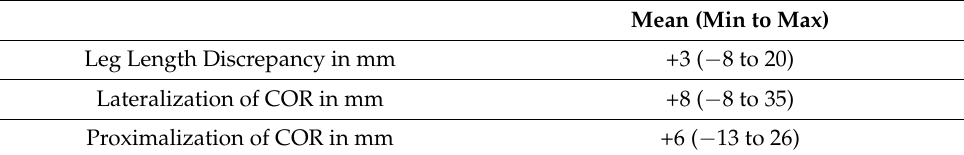
Table 3. Radiographic evaluation.